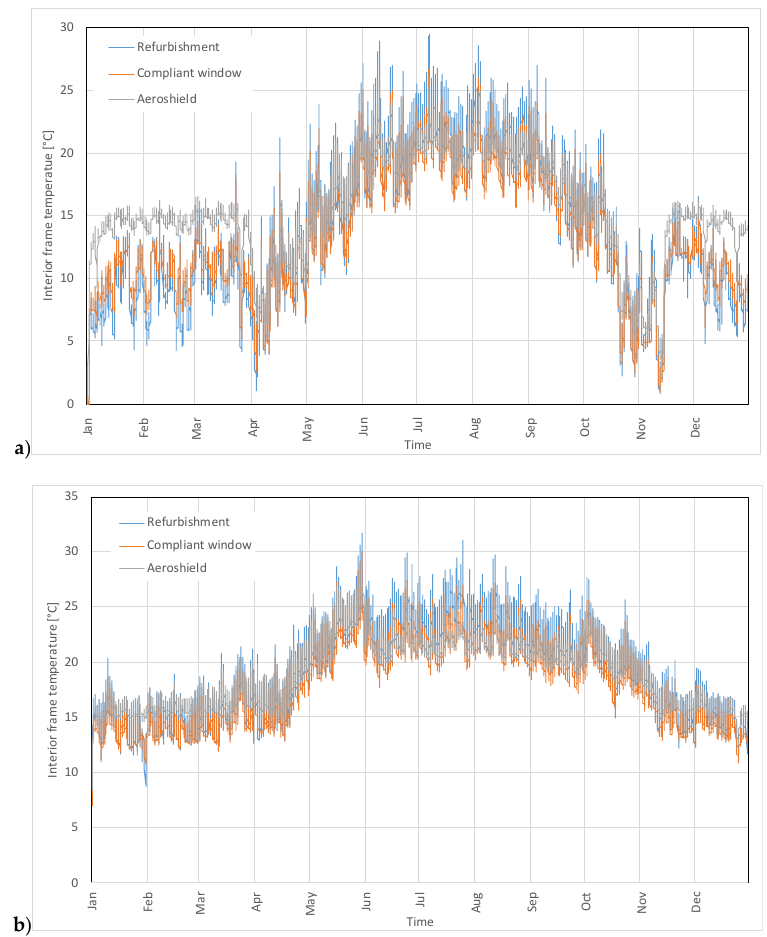
Figure 8. Frame surface temperature for North exposure, plotted with reference to one-year time, in 331 Toronto ( a ) and Bari ( b ). 332